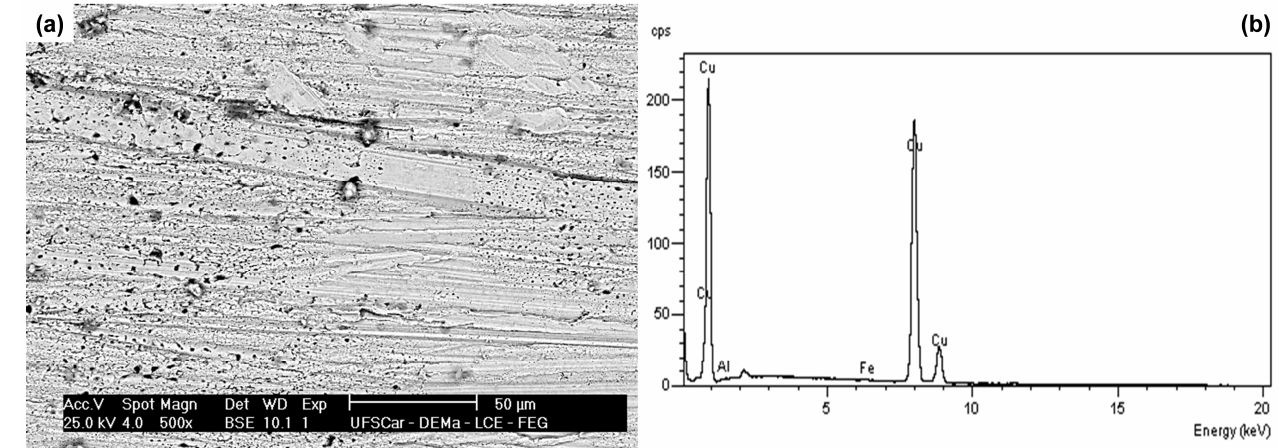
Figure 12. ( a ) Copper deposit micrography obtained by electrowinning of supercritical leachate; ( b ) Deposit EDS spectrum ( b